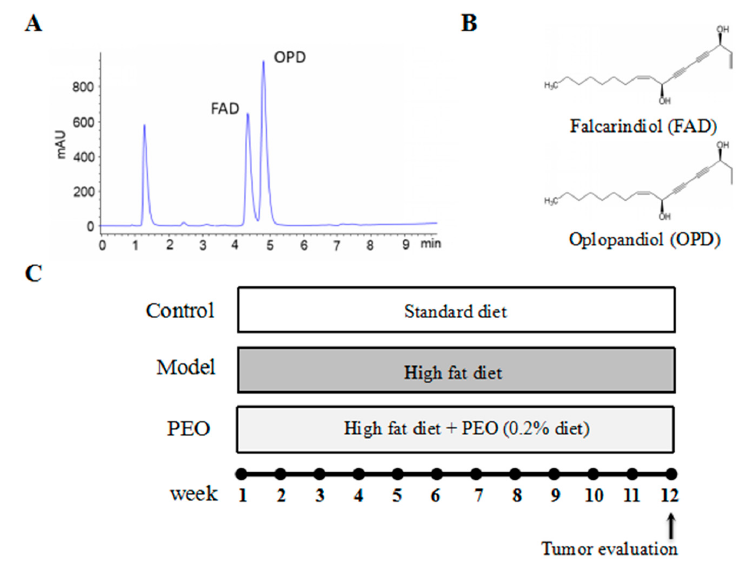
Figure 5. Chemical structures and HPLC analysis of polyynes in PEO extract. HPLC chromatogram of PEO extract recorded at 203 nm is shown in ( A ); Two polyynes in PEO extract were determined: falcarindiol (FAD) and oplopandiol (OPD). The structures of the determined polyynes are shown in ( B ); The percentages of FAD and OPD in PEO extract were 24.39% and 57.90%, respectively. The animal experimental protocol is shown in ( C ).